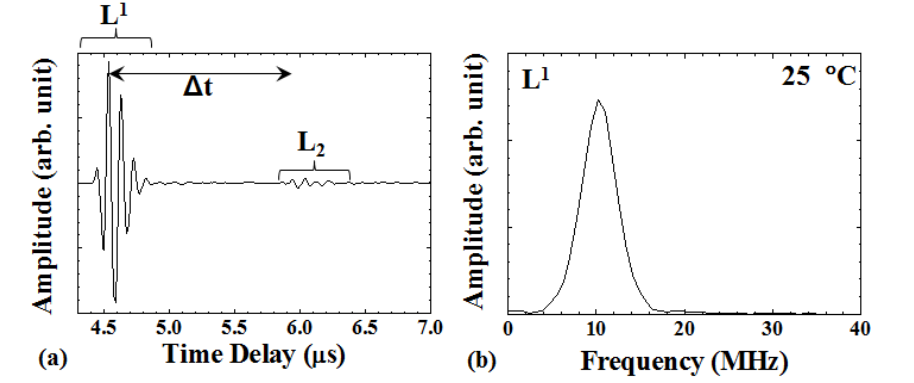
Figure 6. ( a ) Typical ultrasonic signals acquired by UT; ( b ) the frequency spectrum of L 1 signal. The center frequency of the L 1 echo was 10.2 MHz, and the 3-dB bandwidth was 4.6